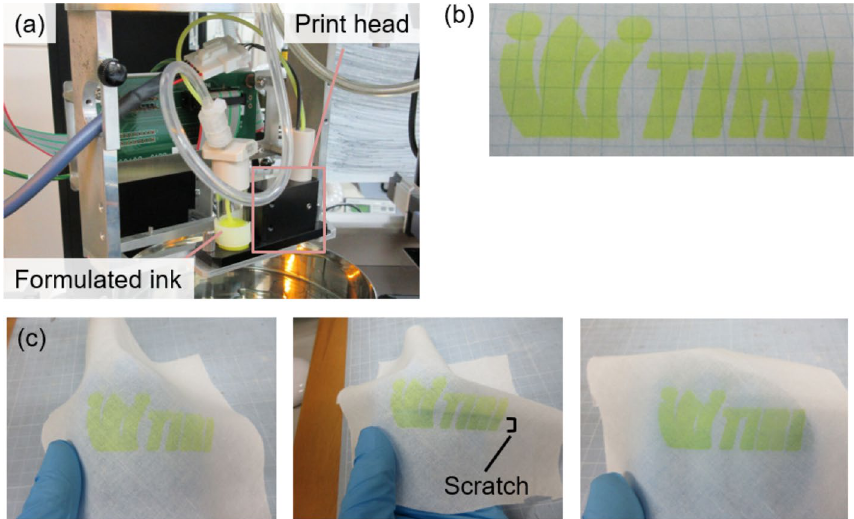
Figure 6. ( a ) Photograph of application in an inkjet printer. ( b ) Printed pattern. ( c ) Printed pattern on a fabric substrate. Response to mechanical pressure and